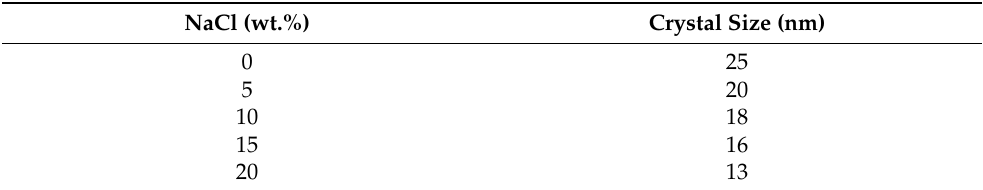
Table 1. Crystallite size of different synthesized powder samples [62]. NaCl